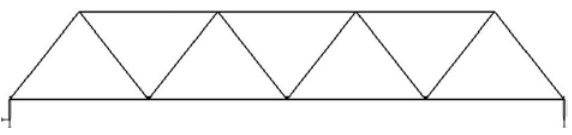
Fig. 11. Beam element computational